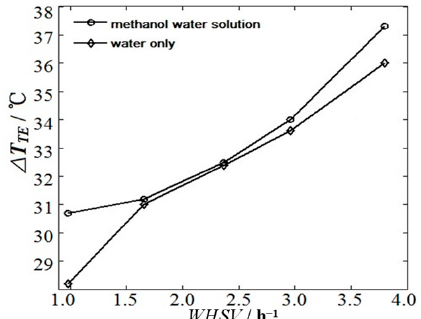
Figure 10. Variation in ∆ T TE with space velocity at different reactants in the reforming